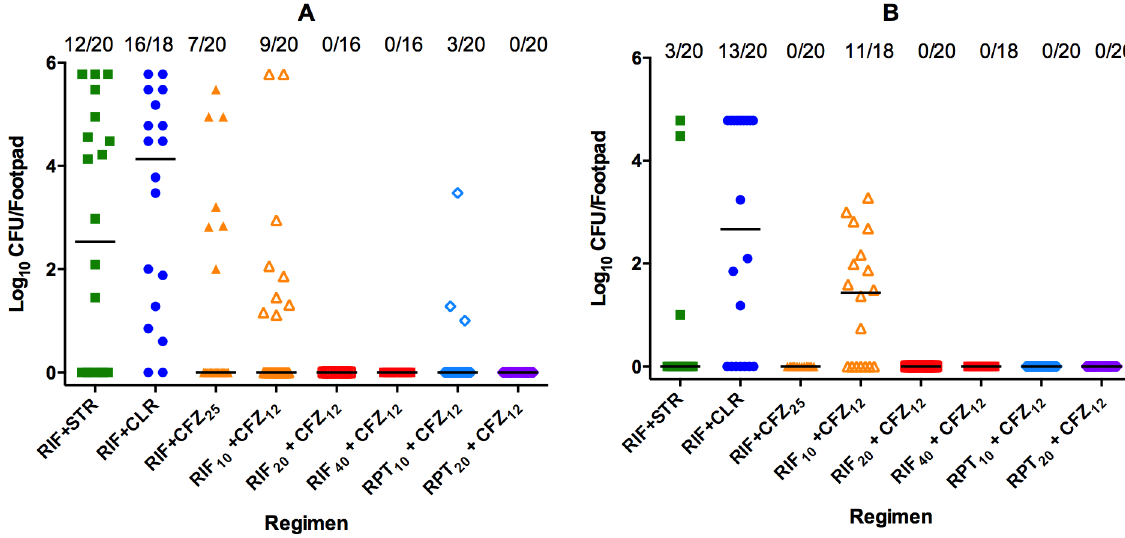
Fig 2. Relapse assessment in mice three months after completion of treatment with a combination regimen for four weeks (A) or six weeks (B). After treatment with one of the control or test combination regimens depicted in Fig 1, both footpads of up to 10 mice per group were assessed for bacterial burden. (RIF+STR, green solid squares), (RIF+CLR, solid blue circles), (RIF+CFZ 25 , solid orange triangles), (RIF 10 +CFZ 12 , open orange triangles), (RIF 20 +CFZ 12 , open red squares), (RIF 40 +CFZ 12 , solid red squares), (RPT 10 +CFZ 12 , light blue diamonds), (RPT 20 +CFZ 12 , purple diamonds). Relapse proportions are indicated above each treatment group. Because gavage accidents resulted in loss of 1 mouse in the RIF 10 +CFZ 25 , and 2 mice each in the RIF 20 +CFZ 12.5 and RIF 40 +CFZ 12.5 groups, these mice were lost to relapse